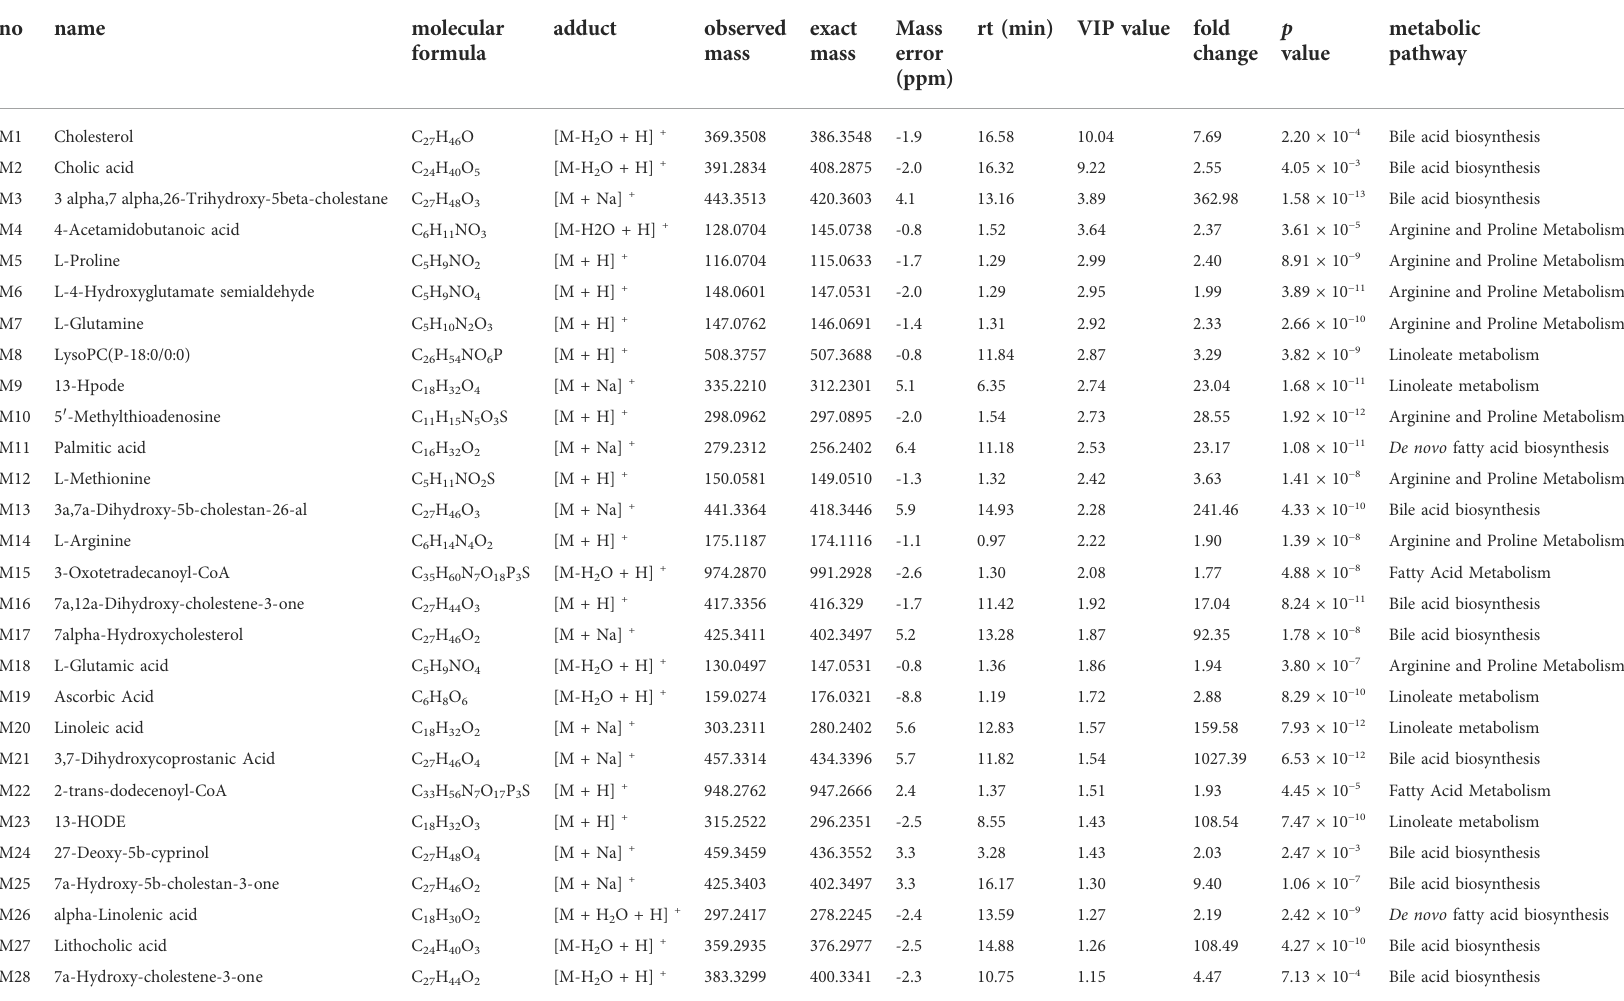
TABLE 3 Potential biomarker from primarily involved six metabolic